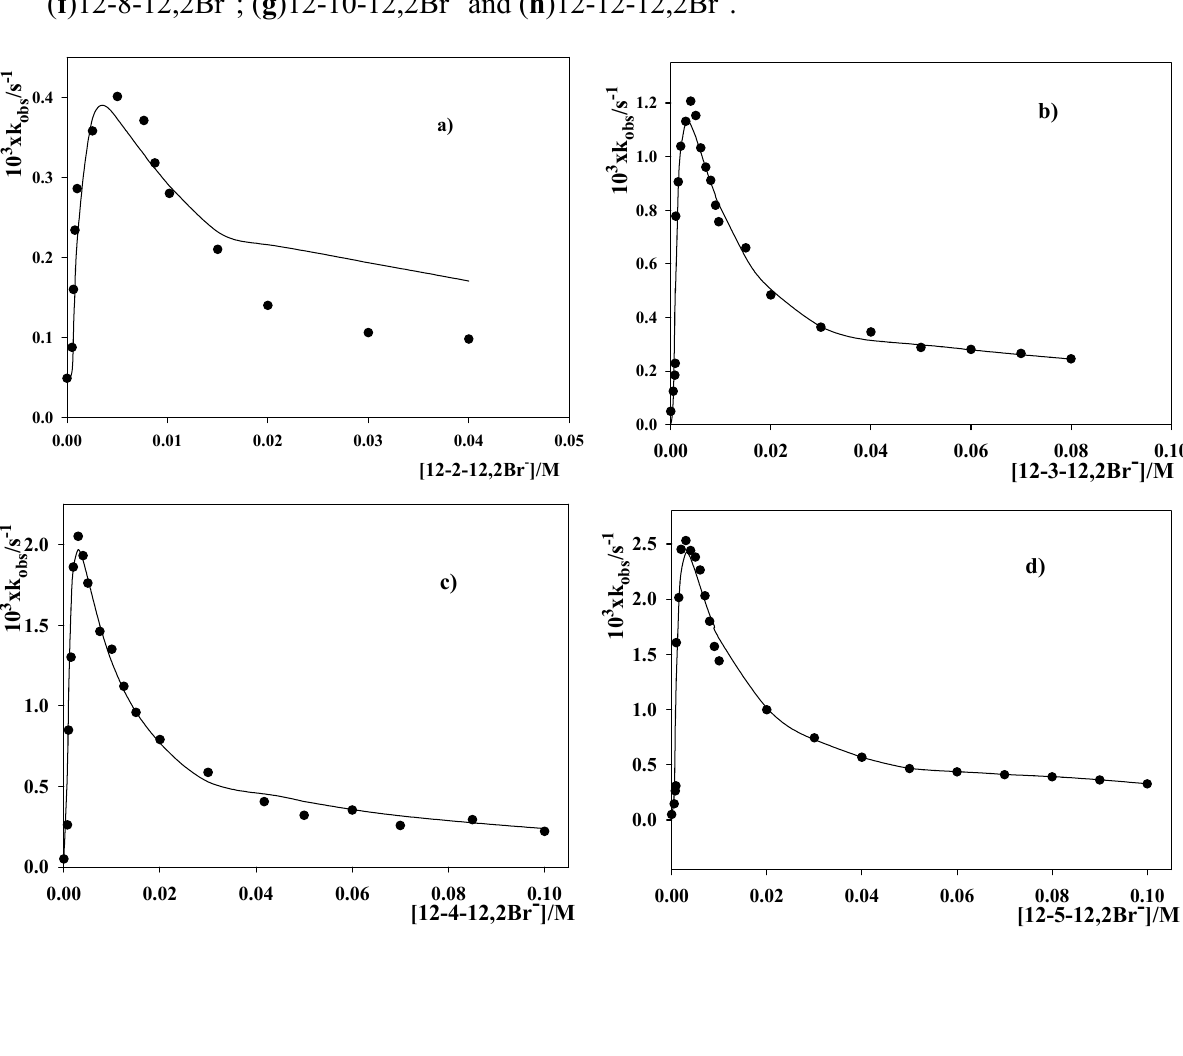
Figure 2. Dependence of the observed rate constant for the reaction 2-( p -nitrophenyl)ethyl bromide, PEB, + OH − on surfactant concentration. [NaOH] = 5 × 10 − 3 M and T = 303 K. ( a ) 12-2-12,2Br − ; ( b )12-3-12,2Br − ; ( c )12-4-12,2Br − ; ( d )12-5-12,2Br − ; ( e )12-6-12,2Br − ; ( f )12-8-12,2Br − ; ( g )12-10-12,2Br − and ( h )12-12-12,2Br −